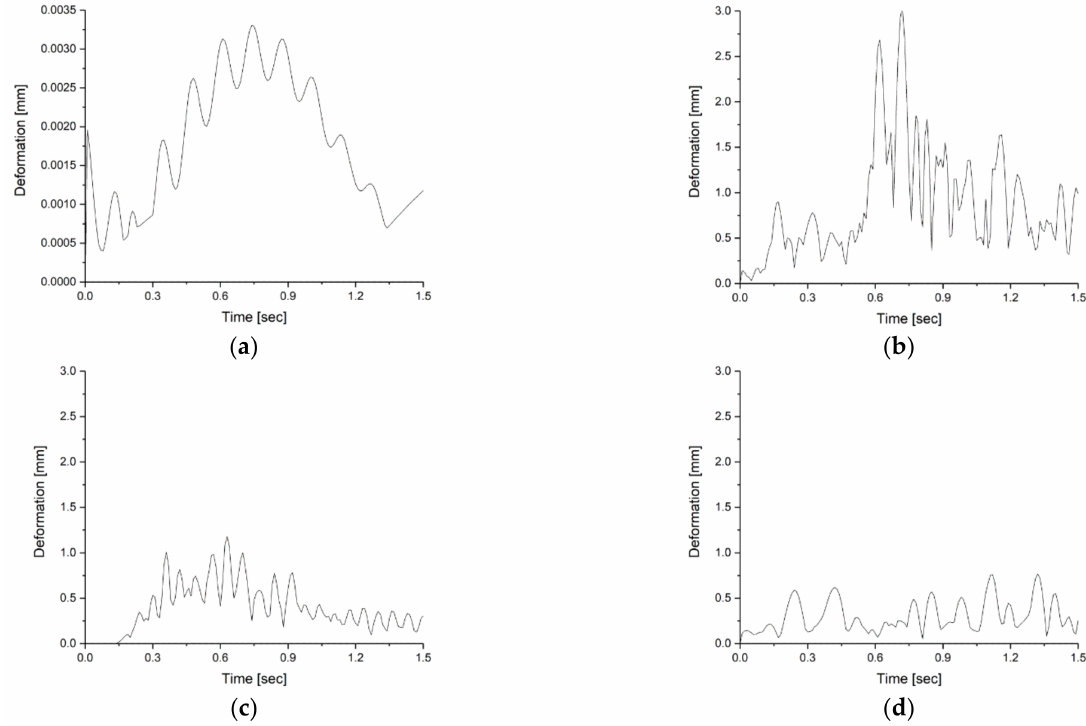
Figure 9. Maximum deformation results according to time. ( a ) Flat course; ( b ) pothole course; ( c ) short-wave course; ( d ) long-wave